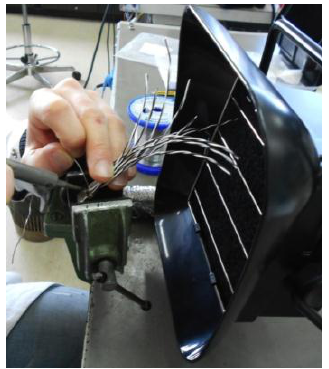
Figure 10. The micro-welding operation under suction (sampling probe was located on the worker’s